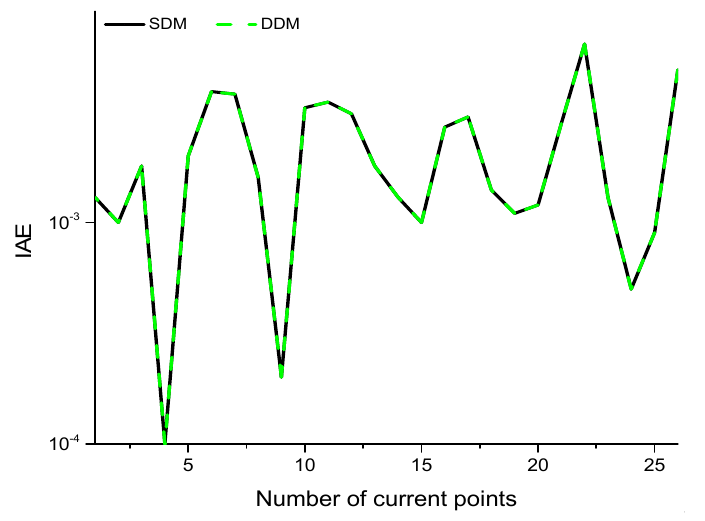
Figure 9. I–V curve of the SDM PV module for experimental and computed current values.